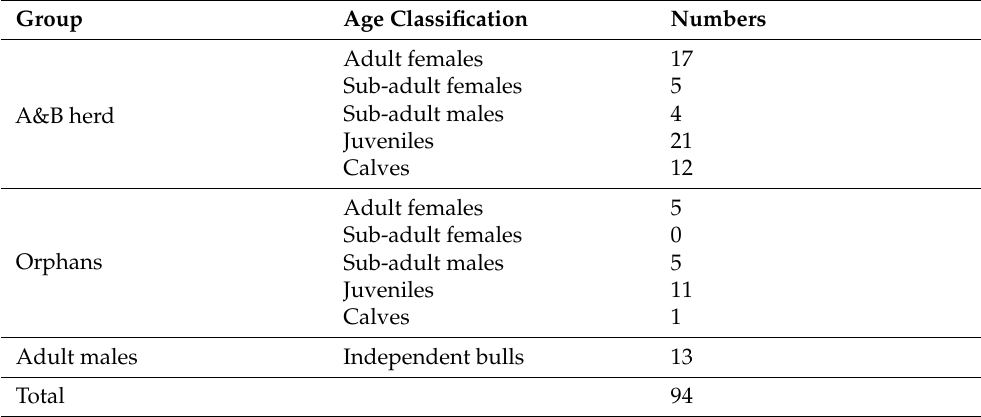
Table 2. Elephant group size and composition at the end of the study period (December 2018). Age classifications: adult ≥ 15 years, subadult ≥ 10 and <15 years, juvenile ≥ 2 and <10 years, and calf < 2